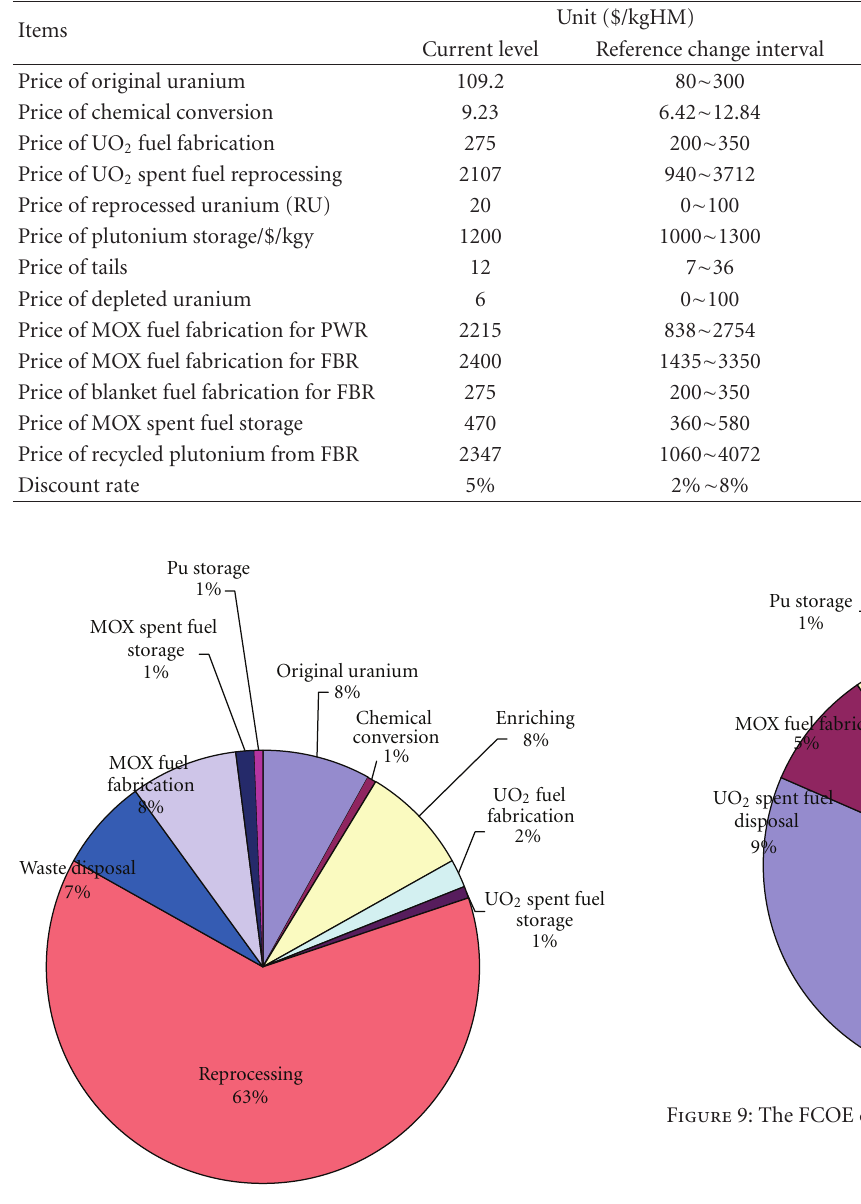
Figure 8: The FCOE composition of using MOX fuel in the PWR.